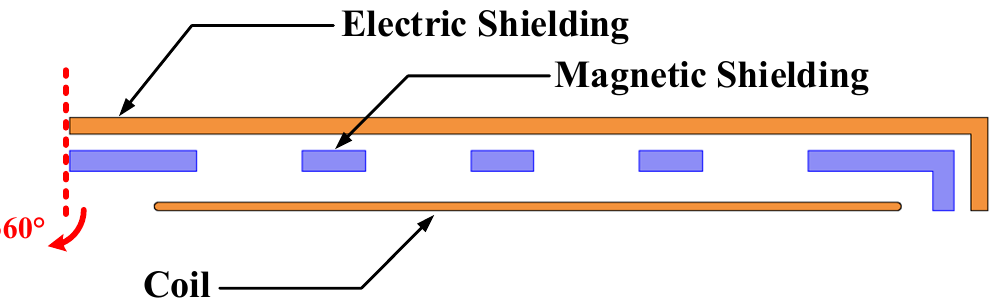
Figure 2. Simplified model of coil for WChS.